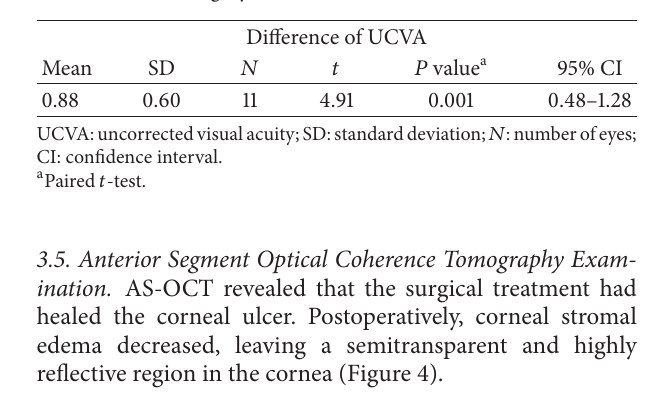
Table 1: Prior treatment for nonhealing corneal ulcers. Table 2: The difference in uncorrected visual acuity (log MAR) before and after